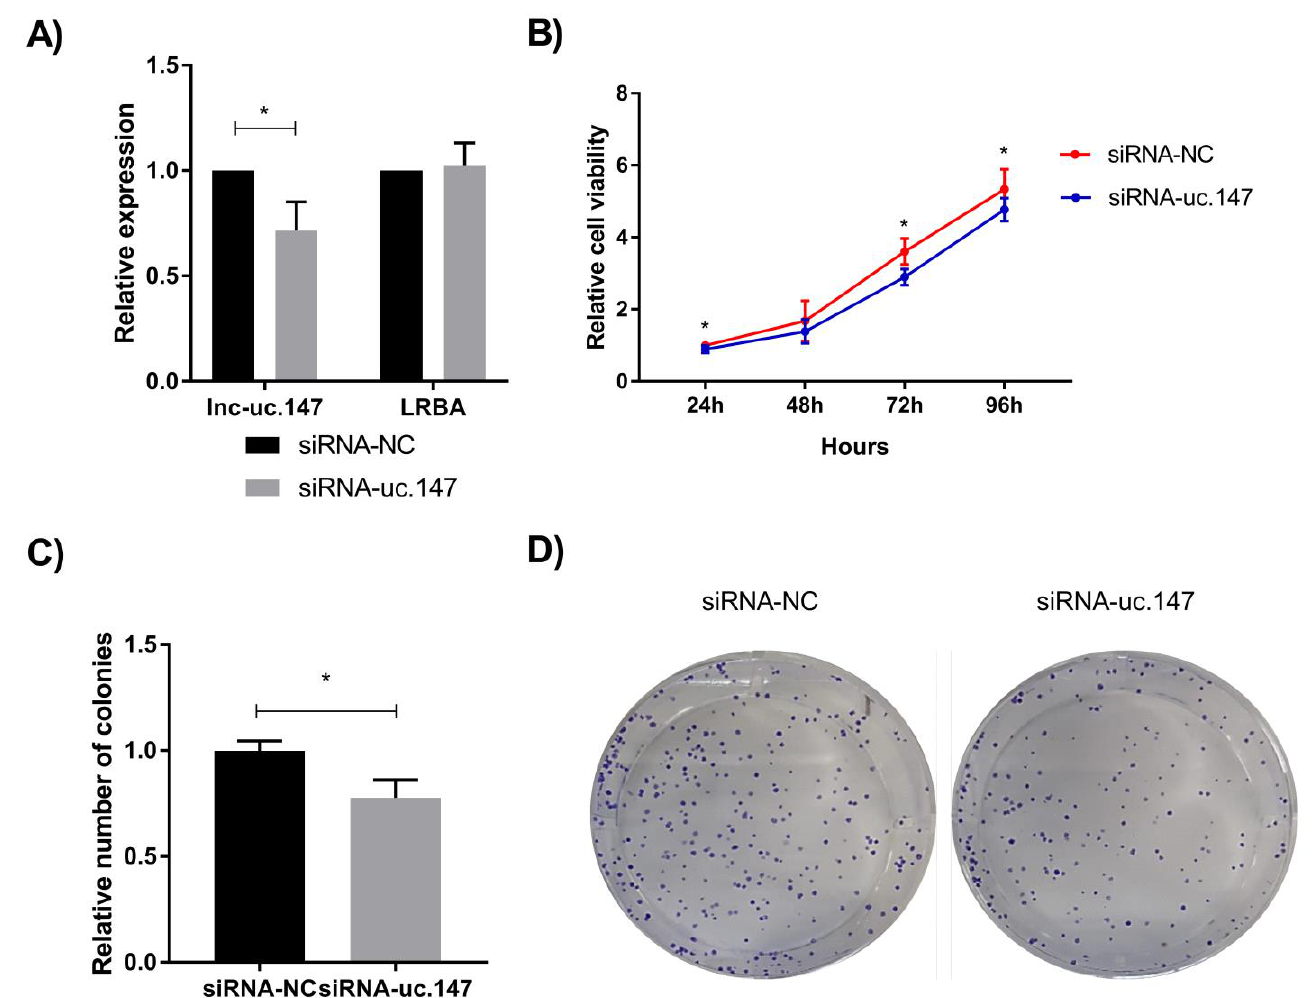
Figure 1. Cell viability and colony formation assays of lnc-uc.147 in HepG2 cells. ( A ) Relative expression levels of lnc-uc.147 and the host gene LRBA after treatment with a siRNA-uc.147 compared to negative control (siRNA-NC). Data normalized by the endogenous controls GAPDH/U6 and the negative control. ( B ) Cell viability in HepG2 cells after treatment with siRNA uc.147 (blue line) and siRNA-NC (red line) at 24, 48, 72, and 96 h. ( C ) Relative number of HepG2 colonies after siRNA treatment. ( D ) Representative plates of colony formation. For all experiments, three independent experiments are represented. Statistical differences were evaluated using the Student t -test. * p < 0.05.